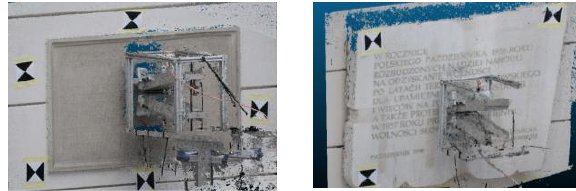
Figure 2. The example of the EM position with dense point cloud used for visualisation.